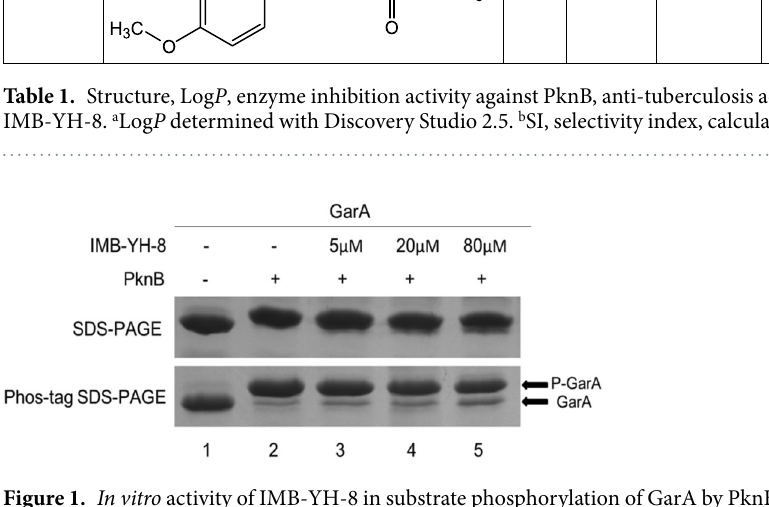
Figure 1. In vitro activity of IMB-YH-8 in substrate phosphorylation of GarA by PknB. Upper panel: Phosphorylated and non-phosphorylated GarA proteins were analyzed on 12% SDS-PAGE alone; Lower panel: Phosphorylated and non-phosphorylated GarA proteins were separated on 12% SDS-PAGE containing 20 μ M Phos-tag acrylamide and 100 µ M MnCl 2 . (full-length gels are presented in Supplementary Figure